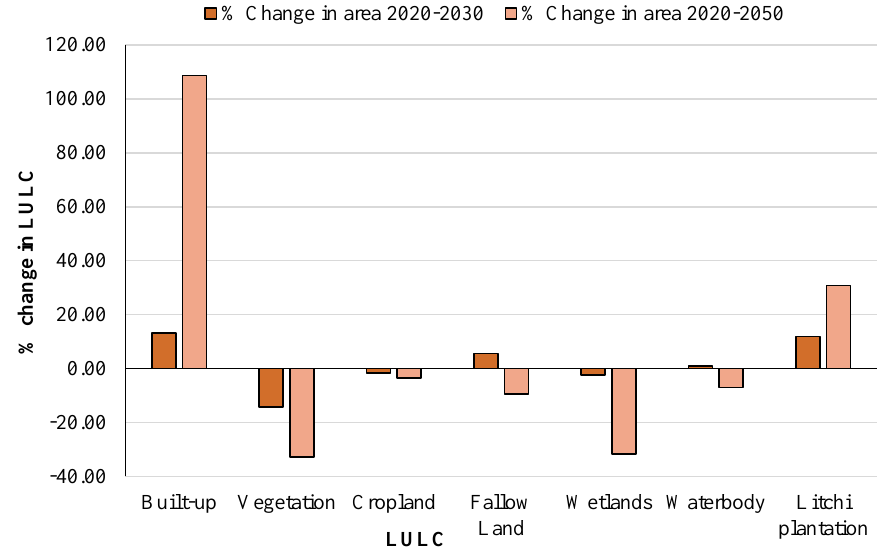
Figure 9. ( a , b ) Predicted LULC maps for the years 2030 and 2050. Table 7. Area estimates of predicted LULC in hectares.